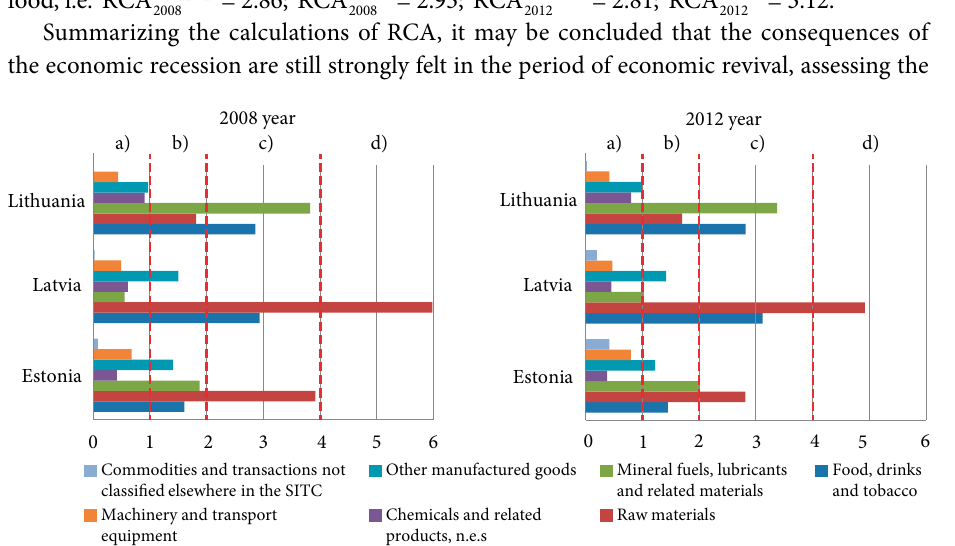
Fig. 2. Industrial RCa indexes of the Baltic states in the EU market in 2008 and 2012 Source : calculated by the authors with reference to the data of Eurostat